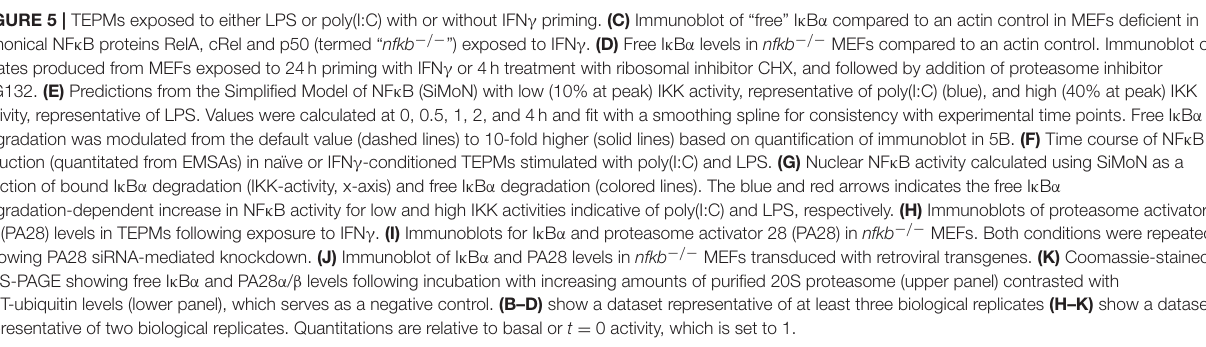
degradation of I κ B α in this cell-free system ( Figure 5K , upper), and this finding was specific to I κ B α as the use of ubiquitin as the substrate in the same assay showed no change upon addition of PA28 proteins ( Figure 5K ,